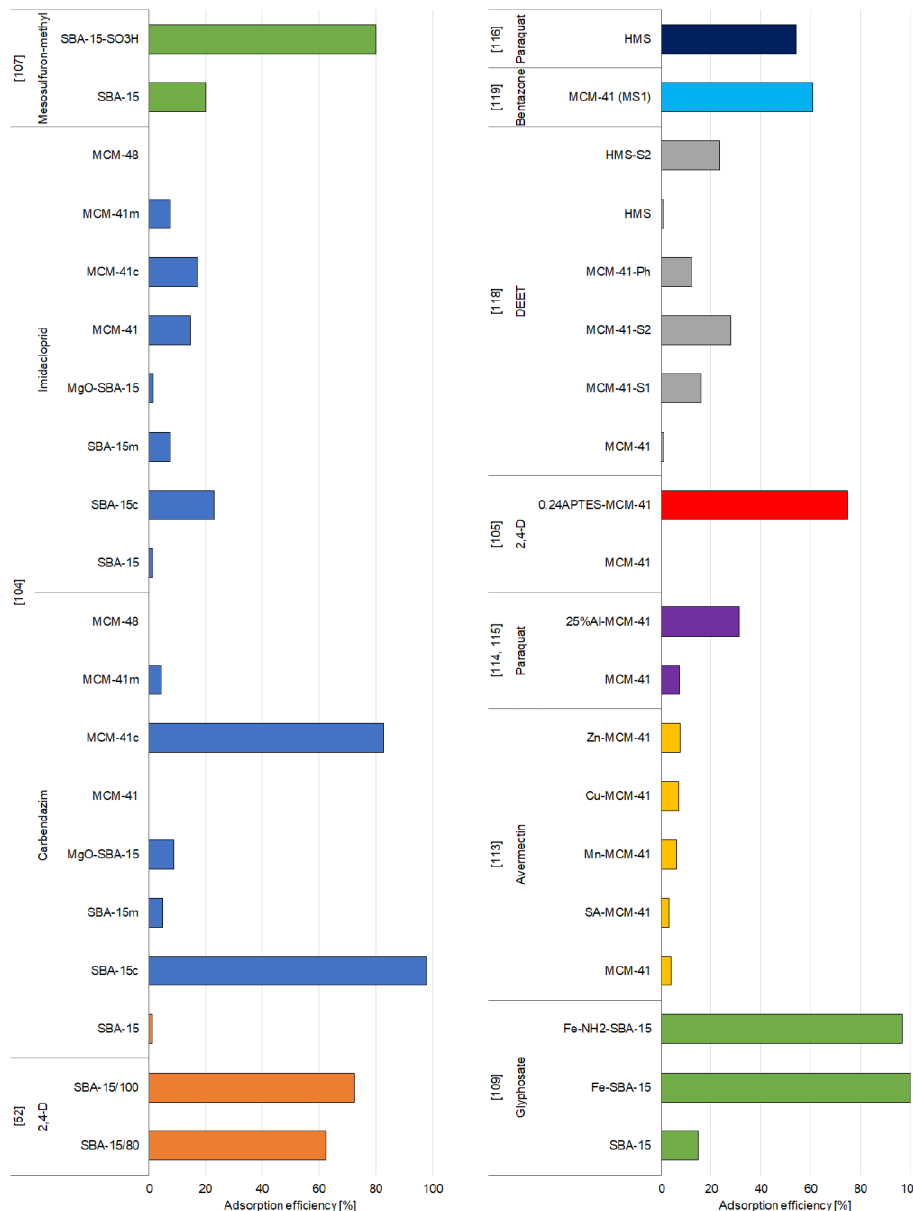
Figure 4. Effectiveness of removal of different groups of pesticides by mesoporous silica materials.